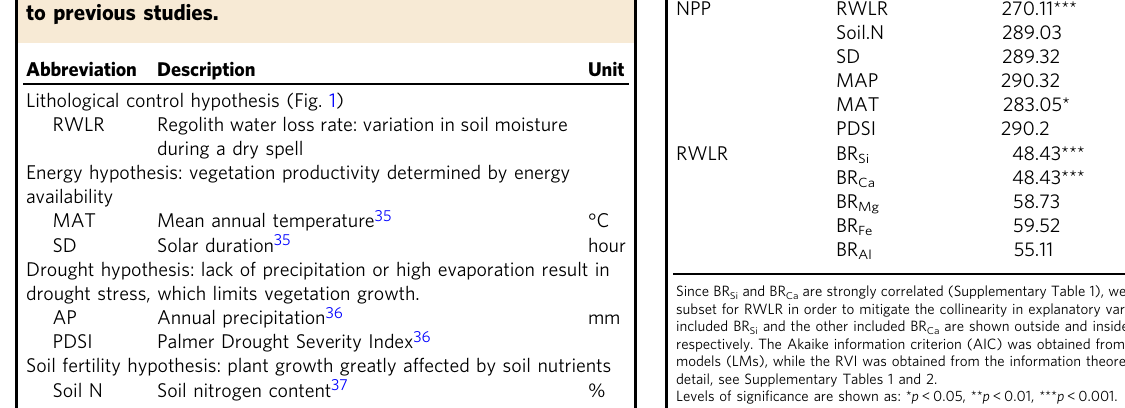
Table 1 Set of hypotheses and related predictor variables used for analyzing the spatial variation in vegetation productivity, the selection of competing hypotheses account to previous studies.